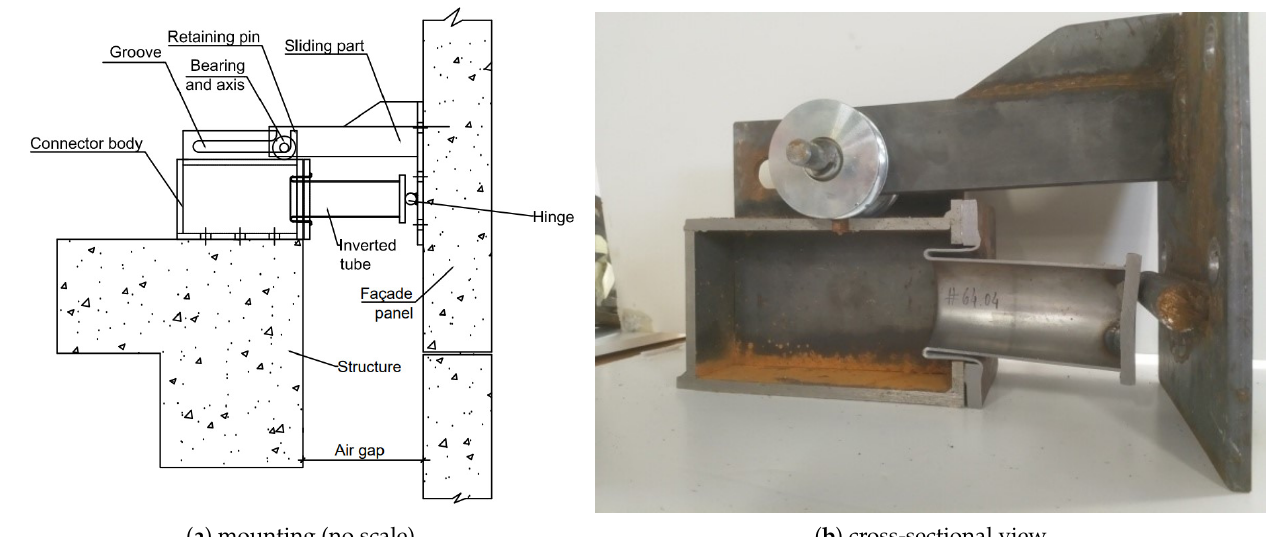
Figure 1. Energy absorbing connector.